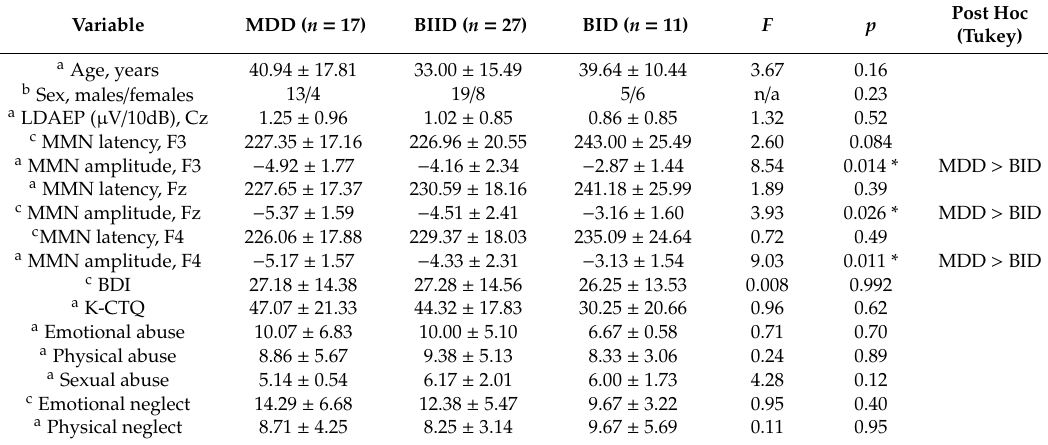
Table 1. Comparison of demographic and clinical variables among groups with major depressive disorder, bipolar I disorder, and bipolar II disorder classified according to clinical diagnosis based on the DSM-5.